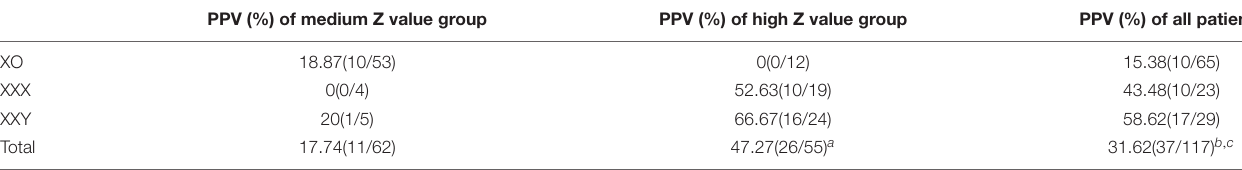
PPV, positive predictive rate. Medium Z value group: patients with a Z-score between optimal cutoff Z-score and plus or minus three. High Z value group: pregnancies with positive NIPS results at Z-score > the absolute value of optimal cutoff value. a Stand for medium Z value group vs. high Z value group, P = 0.000607. b Stand for medium Z value group vs. all patients, P = 0.046059. c Stand for high Z value group vs. all patients, P = 0.046954.